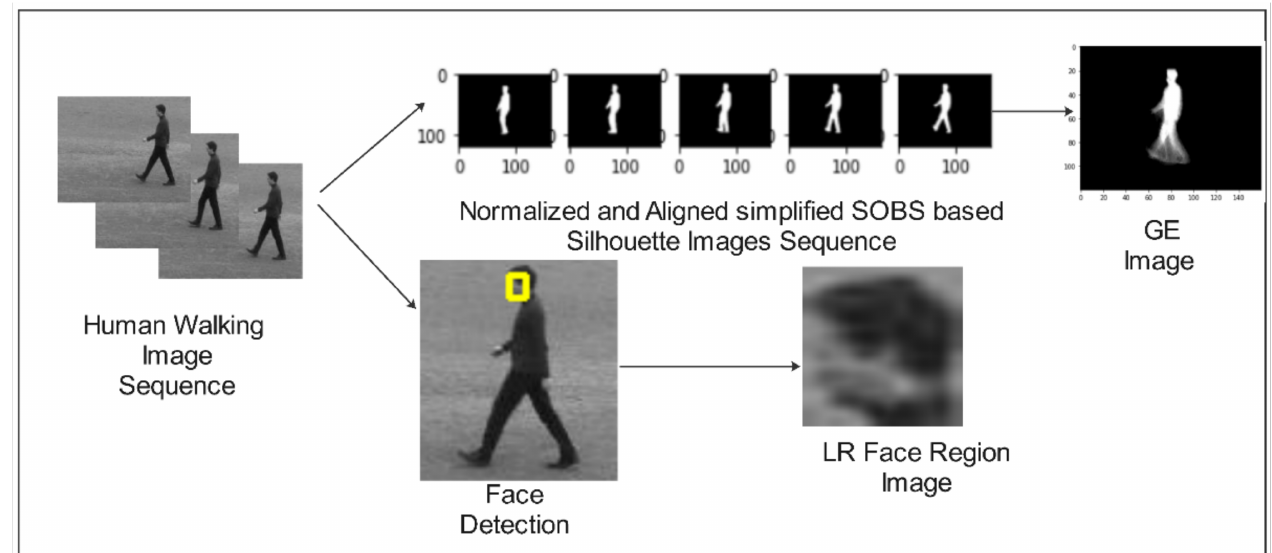
Figure 3. Example of gait energy image and low-resolution face image